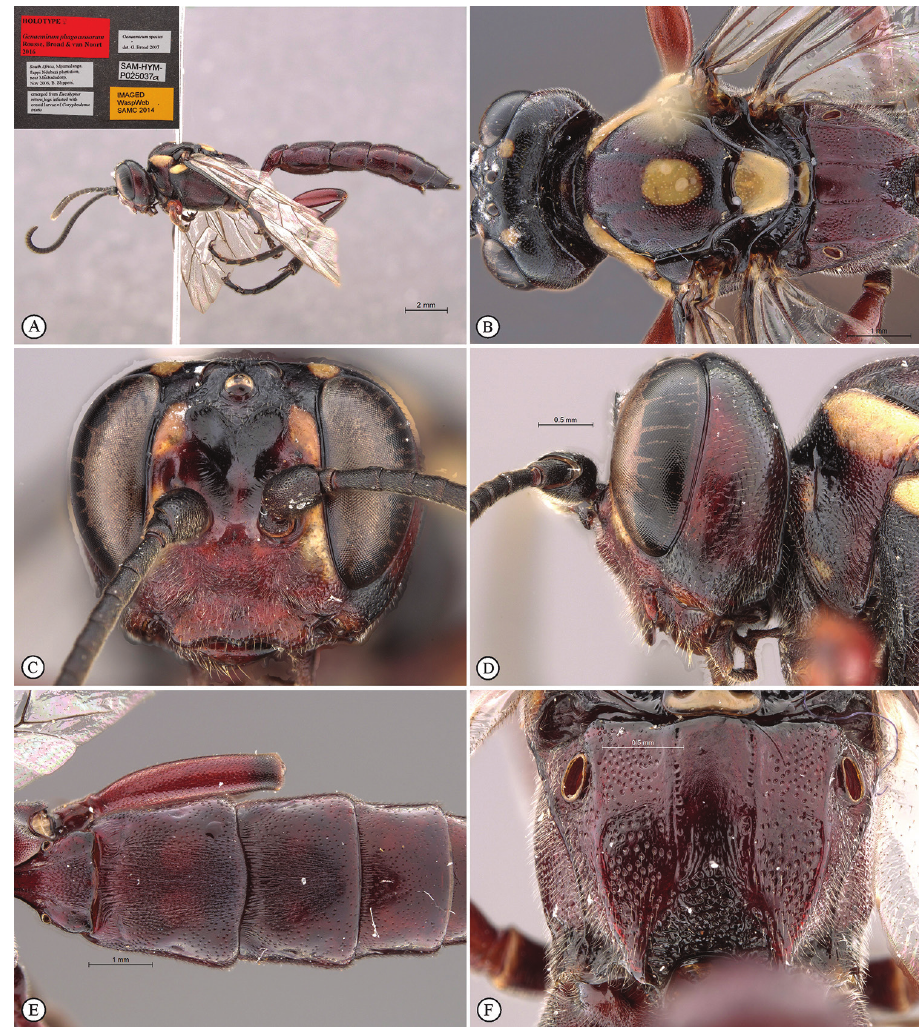
Figure 1. Genaemirum phagocossorum sp. n. Holotype female. A habitus lateral view (inset: data labels) B head, mesosoma, dorsal view C head anterior view D head, mesosoma anterior-lateral view E metasomal tergites 1-4 dorsal view F propodeum, dorsal